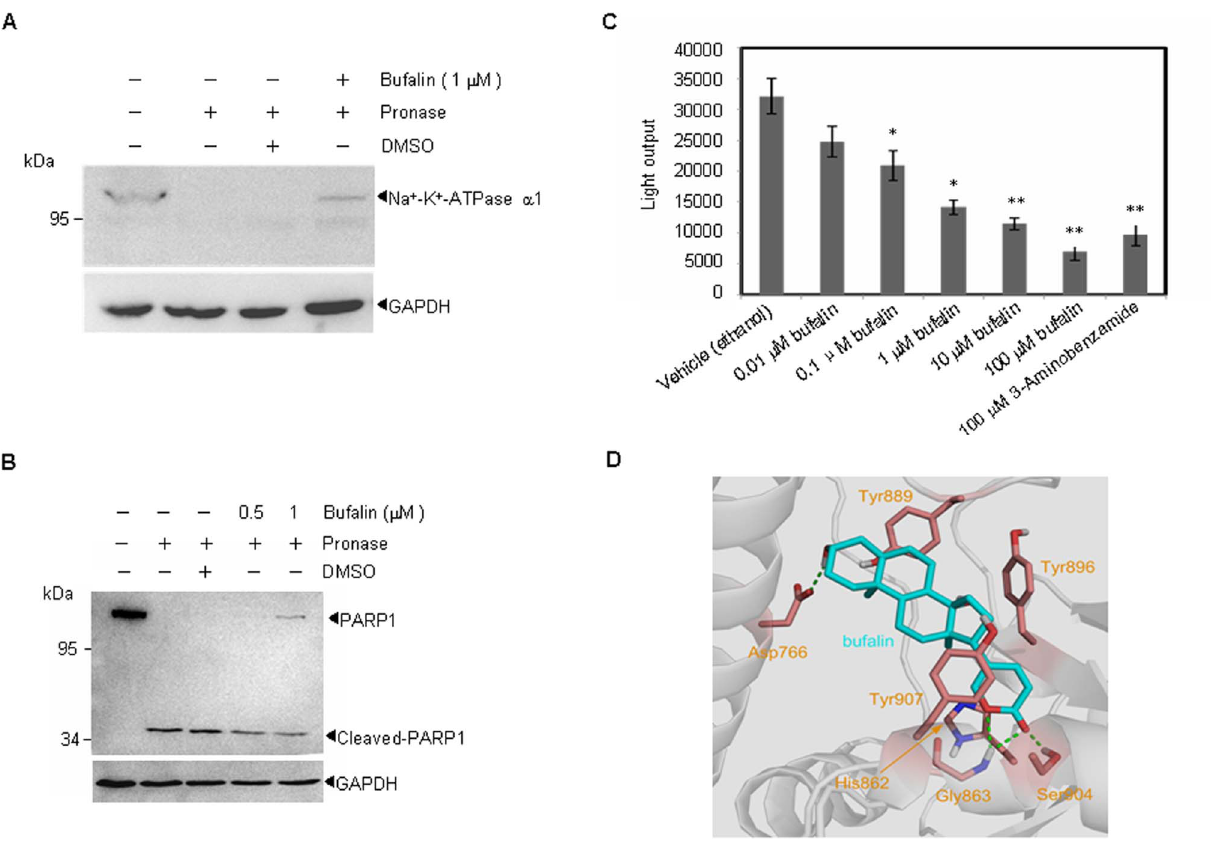
Figure 1. Bufalin interacts with PARP1 and inhibits PARP1 activity invitro . (A–B) Whole cell lysates of U266 cells were incubated with bufalin followed by digestion with pronase according to ‘‘Materials and Methods’’. Then, the degree of Na + -K + -ATPase (A) or PARP1 (B) degradation was determined by western blot. All experiments were repeated for three times. (C) PARP1 activity was measured as described in the ‘‘Materials and Methods’’ in the presence or absence of bufalin (concentrations indicated), 3-Aminobenzamide (100 m M) was used as a positive control. All values represent means 6 S.D. of three independent experiments, each performed in triplicate ( * P , 0.05, ** P , 0.01, compared with the vehicle control). (D) The predicted binding mode of bufalin to human PARP1. PARP1 and bufalin are respectively displayed as cartoon and stick. Side chains of crucial residues in the binding site are shown as stick and labeled. Hydrogen bonds between bufalin and PARP1 are depicted with dotted green lines.